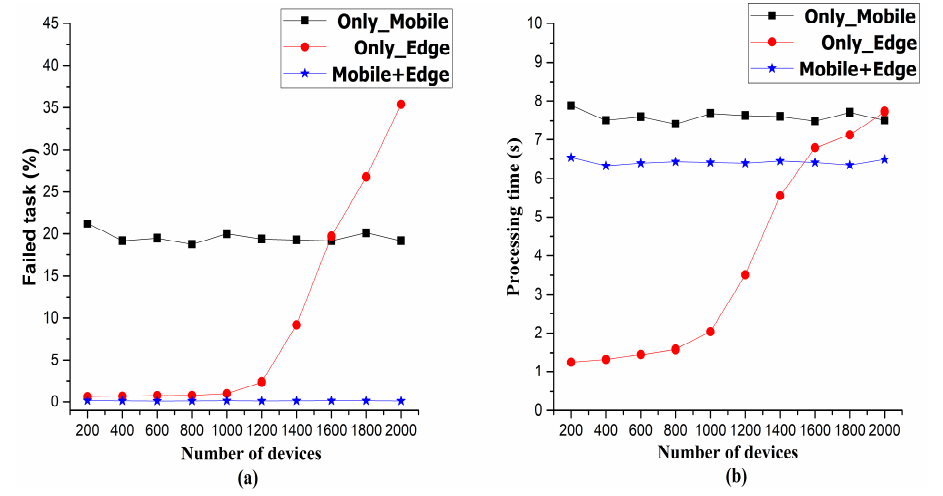
Figure 1. Task failure rate and processing time in the MEC (mobile edge computing) environment. (a) Percentage of failed tasks; (b) Processing time.